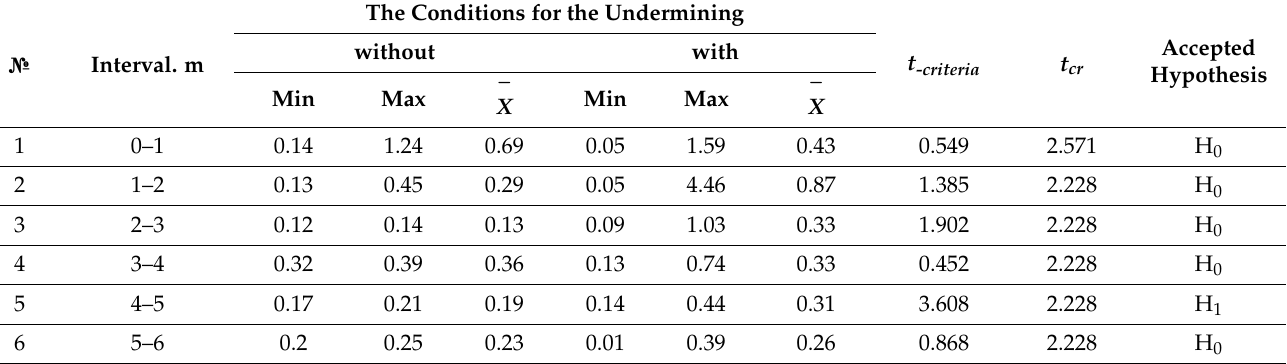
Table 5. The results of the statistical analysis of the experimental studies of the starting gas release of the drift roof.